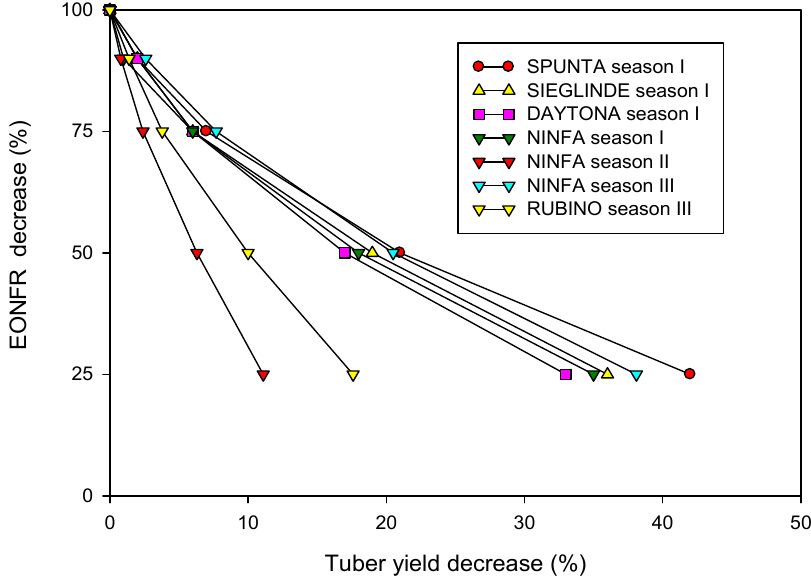
Figure 2. Tuber yield as affected by economically optimum nitrogen fertilization rate in relation to cultivar and season.